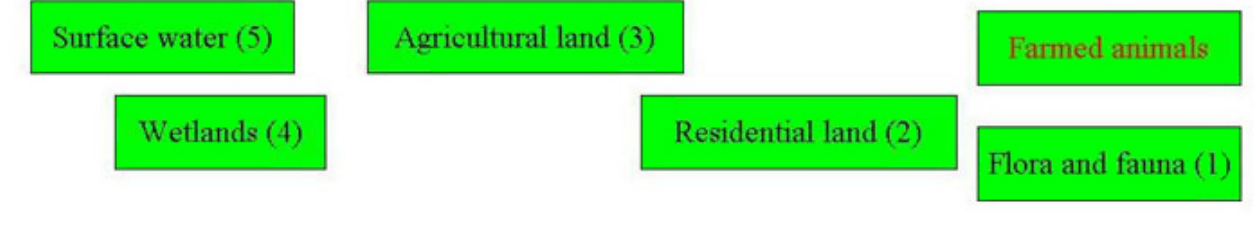
Fig. 3 . ARDI stage 2 at Crocodile River: “What are the main resources of the catchment and the key information needed to support their management?” Words or concepts written in red were added during the later steps of the ARDI. Numbers rank the items from the most (5) to the least important